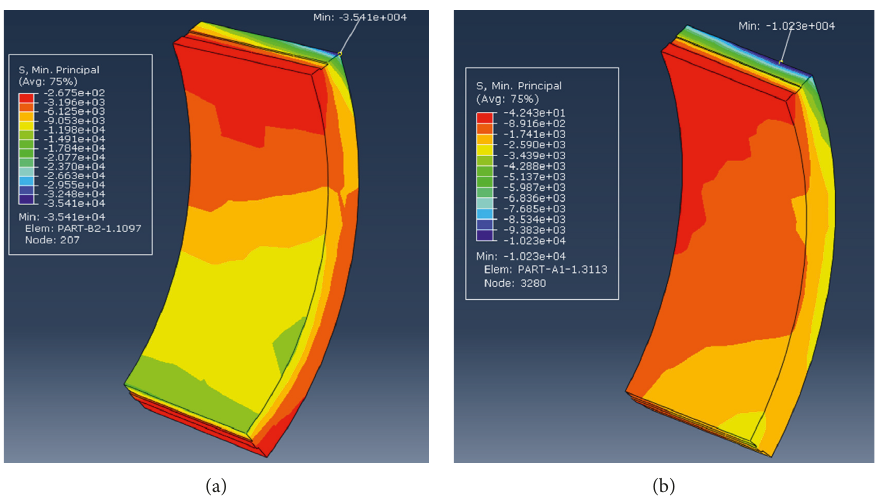
Figure 14: The effect of water head difference on the maximum compressive stress of segment. Water head difference of (a) 18 m and (b) 0 m.